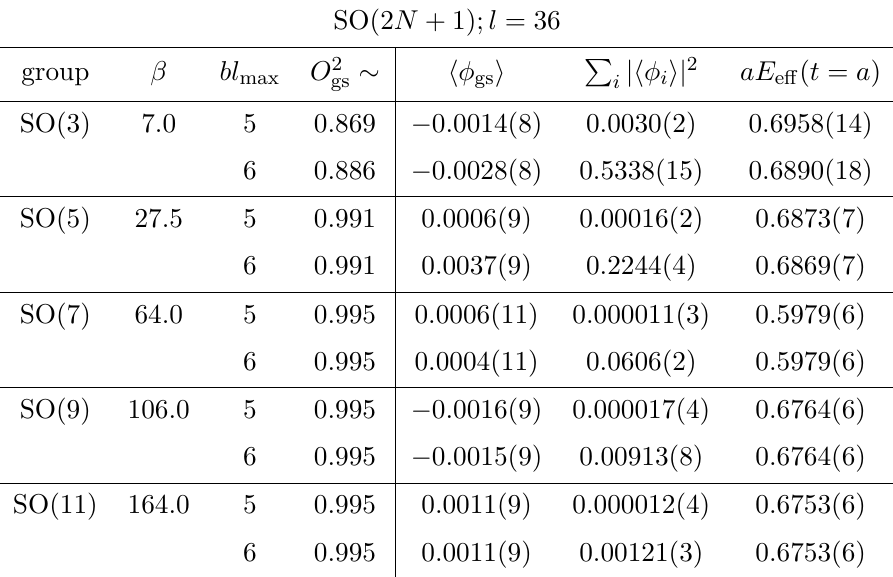
Table 10 . Various overlaps versus N , as described in section 4.2, at the couplings shown, on 36 2 44 lattices for N (cid:21) 5 and on 36 (cid:2) 52 (cid:2) 64 for N =